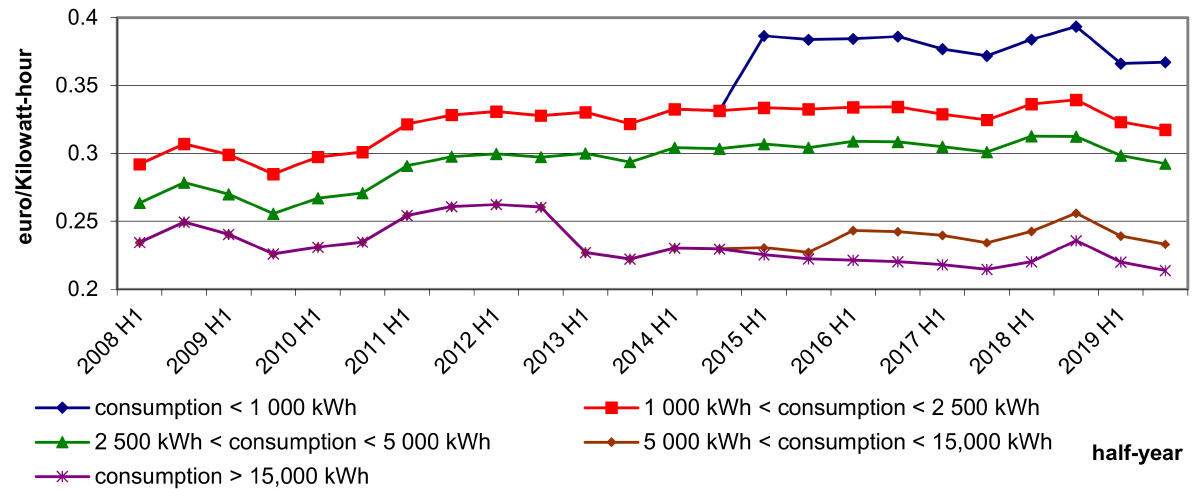
Figure 5. Electricity prices for household consumers in Denmark in 2008–2019.